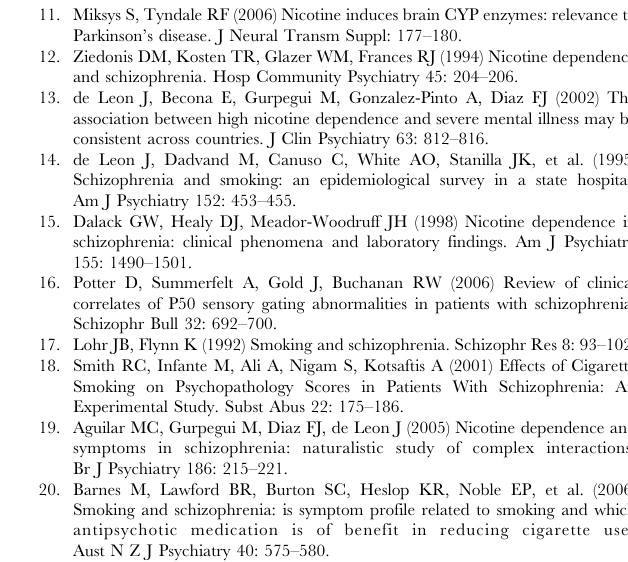
Table S1 The fittings of the MIMIC models on the two independent and the combined study